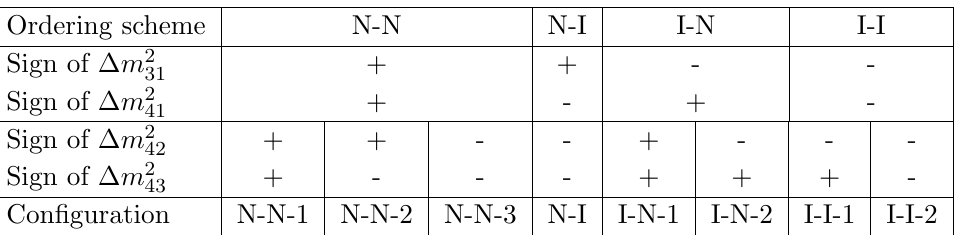
Table 1 . All possible neutrino mass ordering schemes and con(cid:12)gurations in the four-neutrino